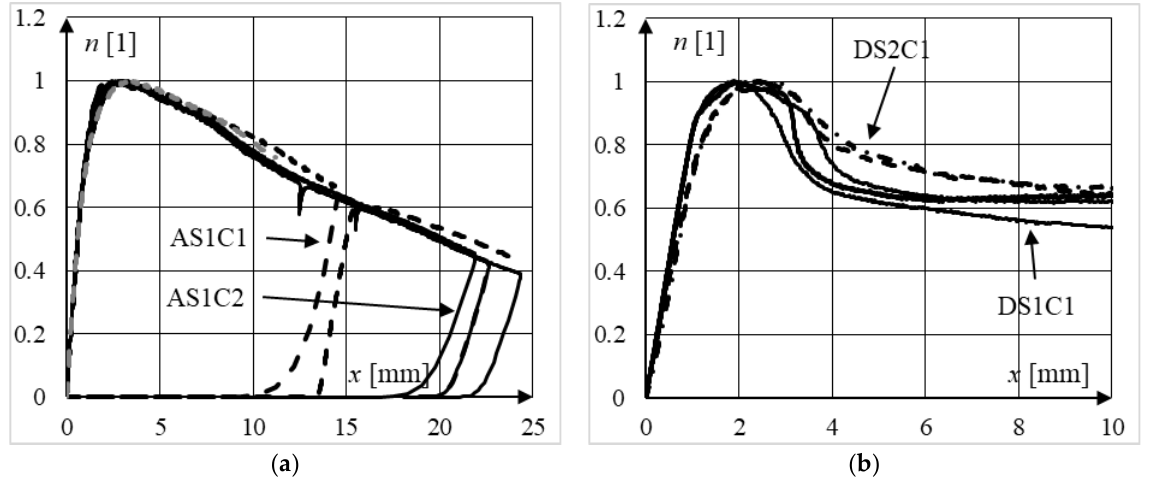
Figure 16. Comparison of normalized equilibrium paths of: ( a ) slender elements from series AS1C1 and AS1C2 (different concrete strength), ( b ) moderately slender columns made from the same grade of concrete and different grades of steel, series DS1 and DS2.